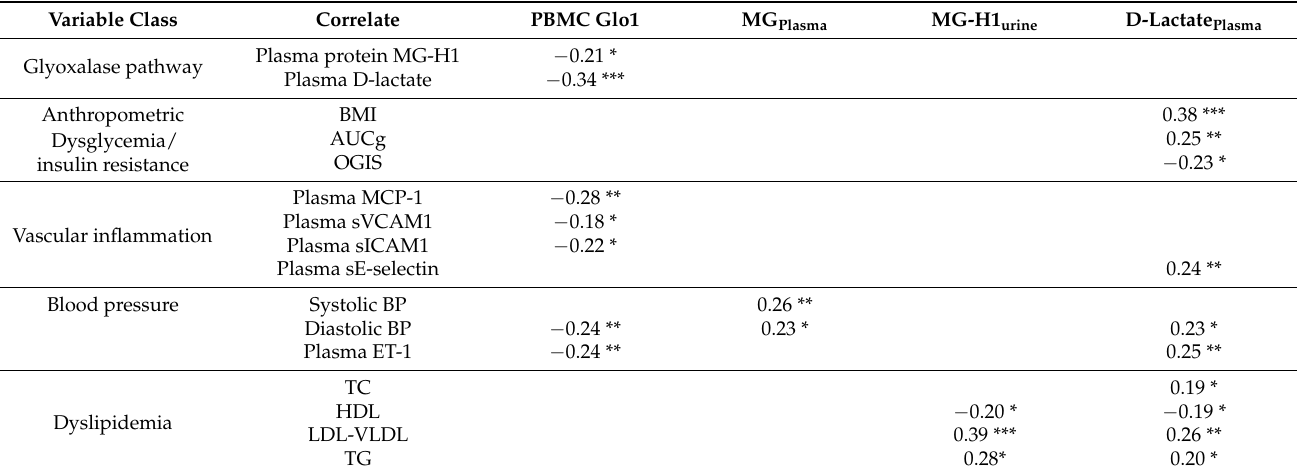
Table 1. Correlation of variables throughout the HATFF study in all